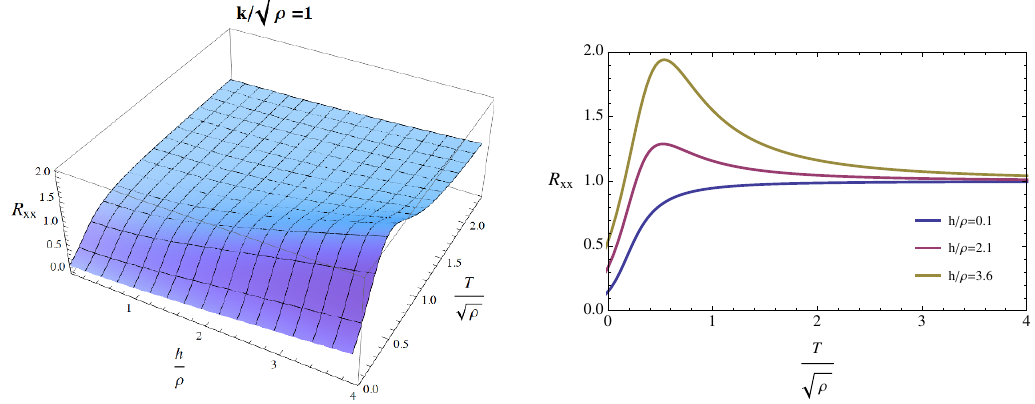
p (cid:26) . We choose